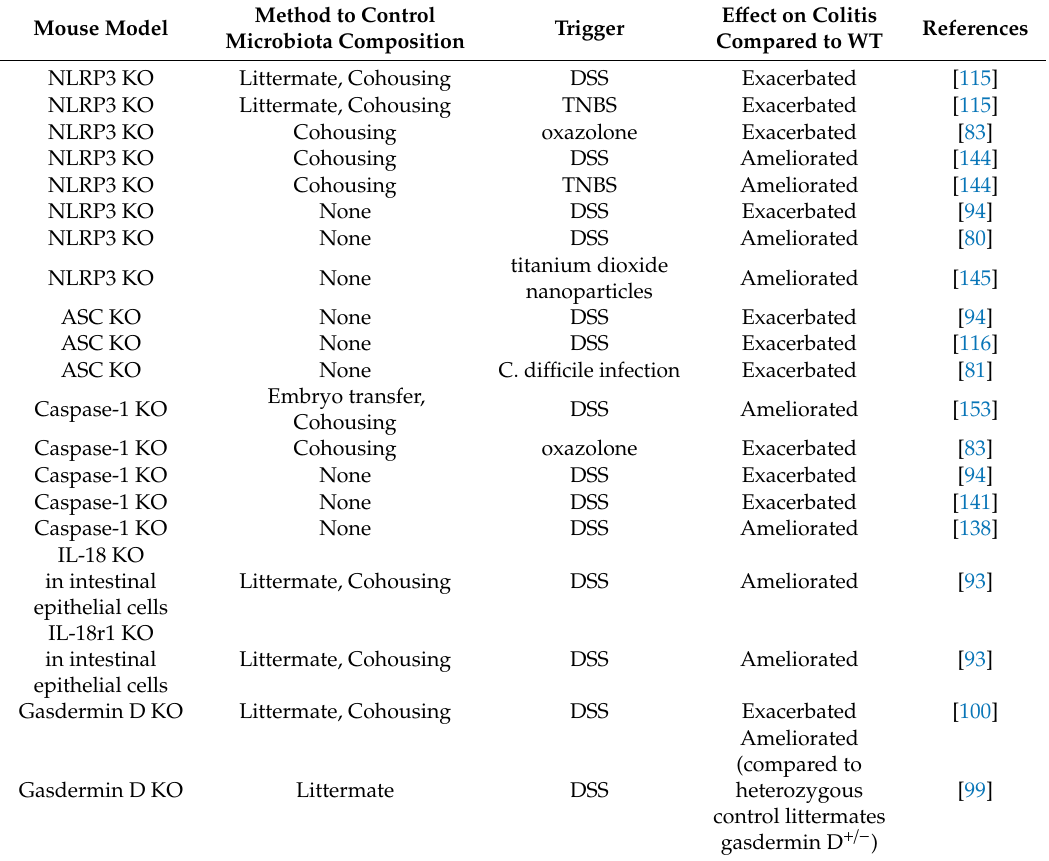
Table 1. Relationship between the e ff ect of NLRP3 inflammasome-related KO mice on colitis and the method used to control the microbiota